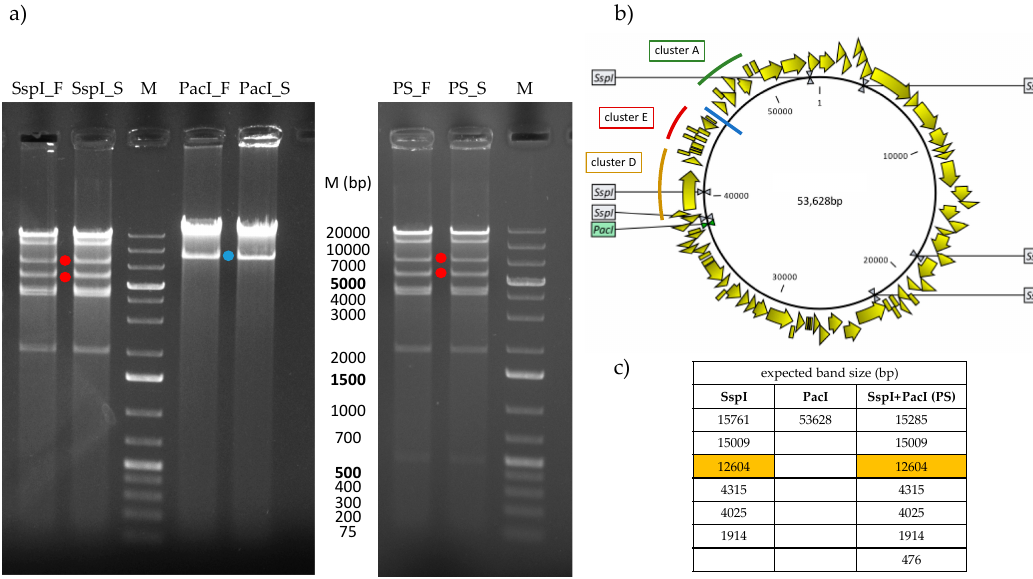
Figure A4. ( a ) Restriction pattern of S144 DNA by using enzymes SspI, PacI (on the left) and the two enzymes together (PS; on the right). After each restriction, DNA has been denatured and cooled down to room temperature in a fast (F) or slow (S) way. The bands size of the marker (M) are indicated in the column in the centre between the two gels. Dots indicate not expected bands from DNA restriction with SspI (red) and PacI (light blue). ( b ) S144 genome with SspI and PacI restriction sites, clusters D, E and A and putative termini position (blue line) indicated. ( c ) Summary of the band size expected from restriction of circular DNA. In yellow, it is indicated the 12,604 bp band that is not present in the gels, between 40,301 bp and 52,905 bp, spanning over clusters E, A and B.